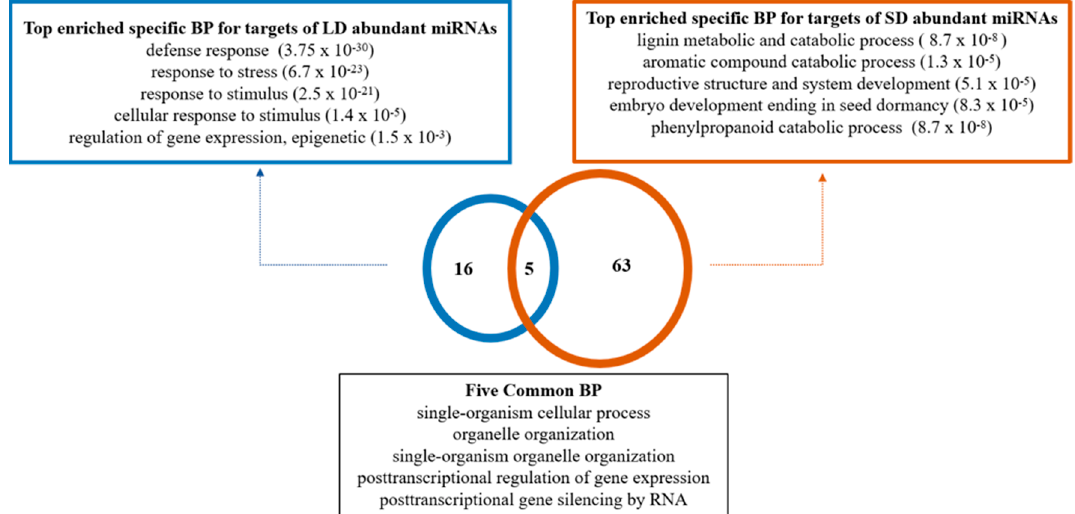
Figure 2. Biological processes (BP) enrichment of predicted targets for abundant miRNAs in V. riparia buds. Blue outlines indicate paradormancy (LD, 15 h) and orange outlines indicate endodormancy (SD, 13 h) related enriched BP for targets. Significance of BP enrichment was calculated using hypergeometric distribution adjusted by set count sizes (SCS) for multiple hypothesis correction. Adjusted p ‐ value is indicated in parenthesis after each biological process GO term.